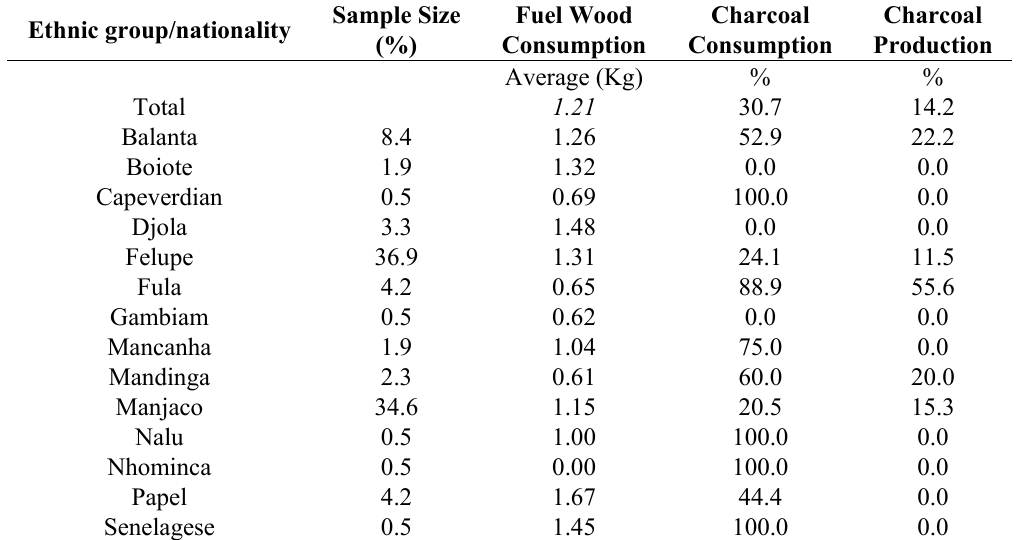
Table 3. Fuel wood and charcoal consumption/production per ethnic